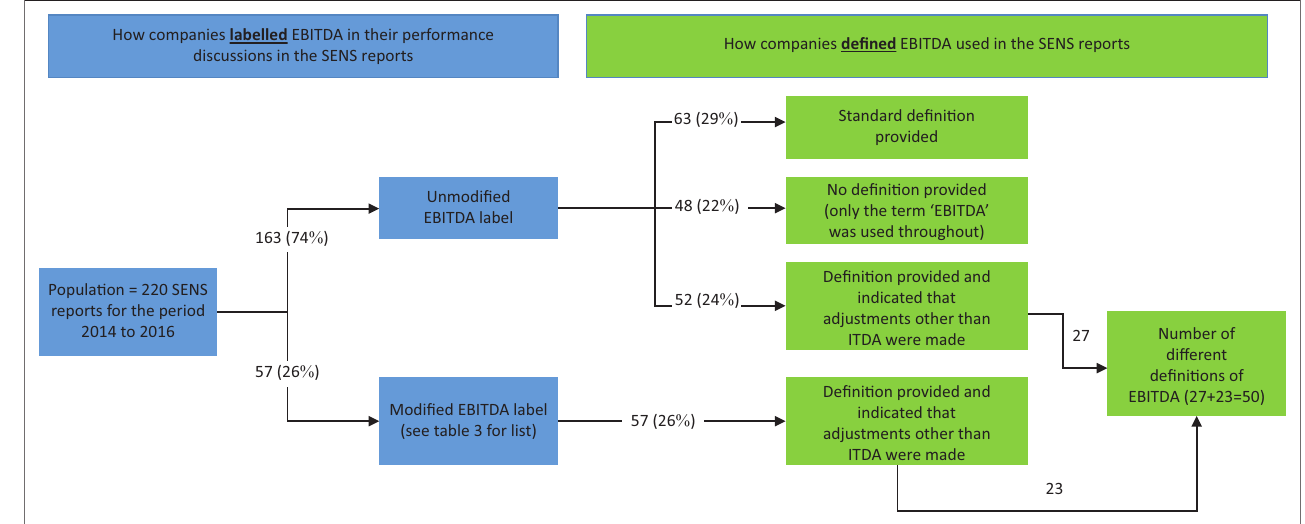
EBITDA, earnings before interest, tax, depreciation and amortisation; ITDA, interest, tax, depreciation and amortisation; SENS, Stock Exchange News Service. Note: All percentages expressed as a proportion of the total population of 220. FIGURE 4: Summary of how companies labelled and defined earnings before interest, tax, depreciation and amortisation in their Stock Exchange News Service reports from 2014 to 2016 ( N = 220).